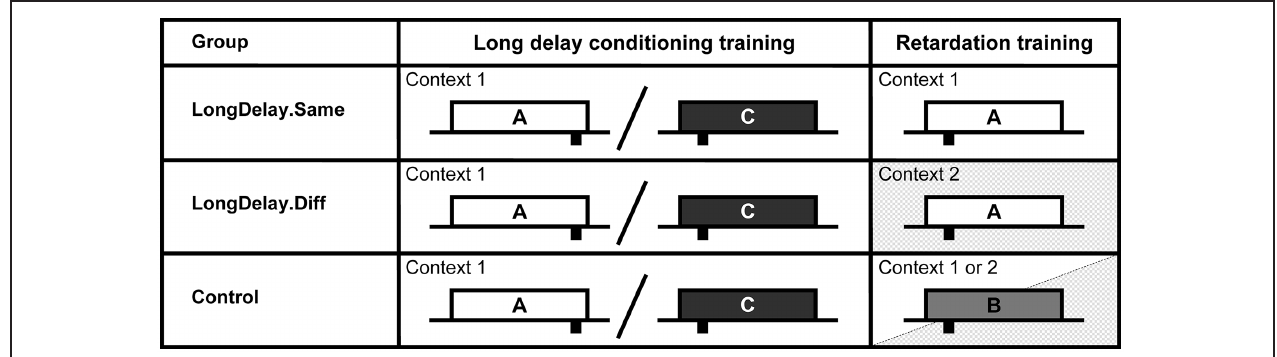
FIGURE 5 | Design of Experiment 2. The white, light gray, and dark gray rectangles represent CSs A, B, and C, respectively. CSs A and B were a 60-s white noise or a 60-s flashing light, counterbalanced within groups. CS C was a 60-s 800-Hz tone. Sucrose pellet USs (represented by black rectangles under the time line) were delivered at either 55 or 10 s after CS onset (represented at the appropriate location under the time). Long delay conditioning training for all groups occurred in Context 1 (white background). Retardation training occurred in Context 1 for Group LongDelay.Same, Context 2 (shaded background) for Group LongDelay.Diff, and in either Context 1 or Context 2 for Group Control. Slashes represent intermixed presentation of CSs during training. See text for details.